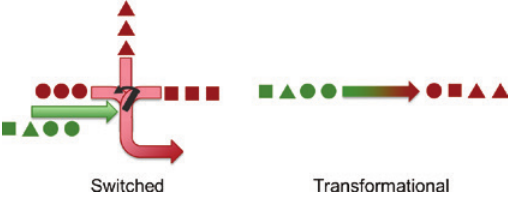
Figure 6: Switched vs. wave mixed processing. Figure 7: Graphical depiction of wave